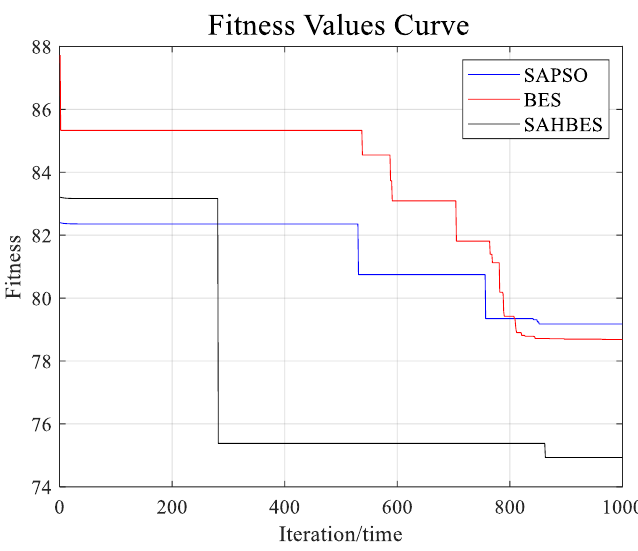
Figure 8. Comparison of the curves of the three algorithms’ fitness values.